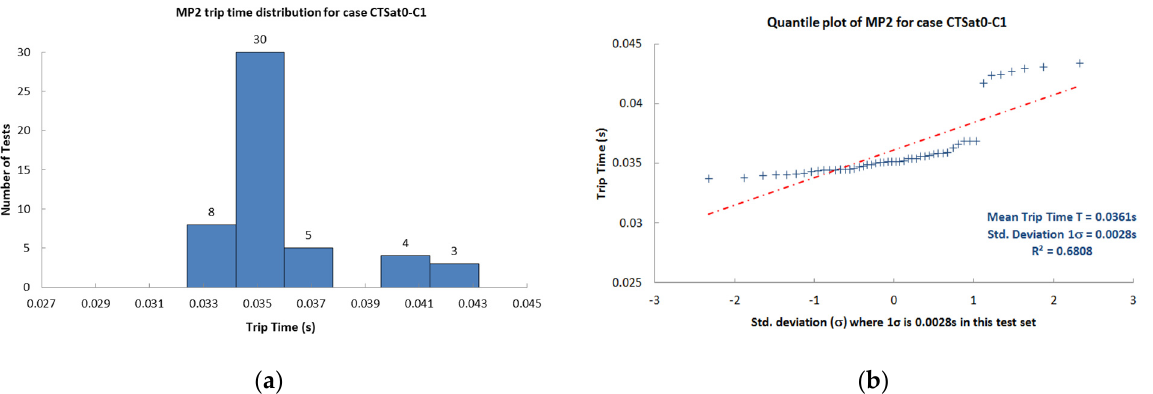
Figure 12. MP2 trip time distributions and quantile plot for case LV-C1 (ideal CT, 1 faulty AMU, 3Ph-G faults at 50% of the feeder).